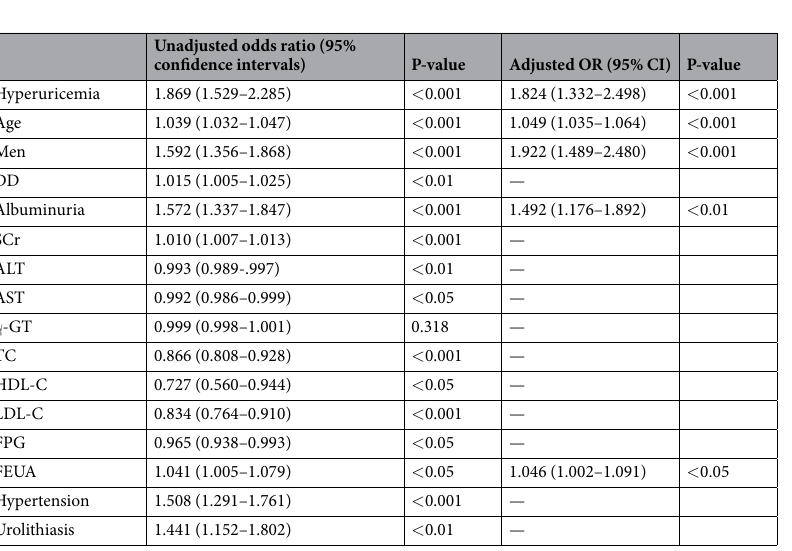
Table 3. Univariate and multivariate logistic regression of factors associated with SRC. SRC, simple renal cysts; DD, duration of diabetes; SCr, serum creatinine; ALT, alanine aminotransferase; AST, aspartate aminotransferase; γ -GT, γ -glutamyl transferase; TC, total cholesterol; HDL-C, high-density lipoprotein cholesterol; LDL-C, low- density lipoprotein cholesterol; FPG, fasting plasma glucose; FEUA, fraction excretion of uric